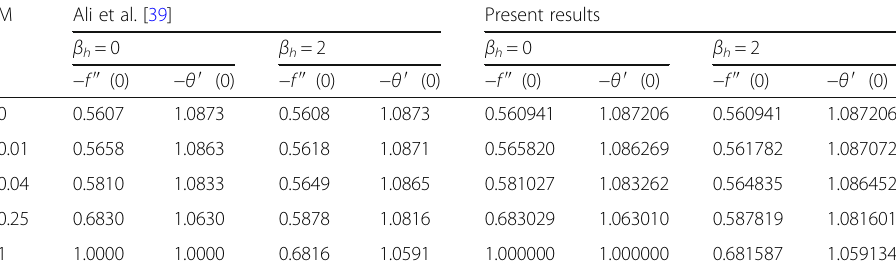
Table 2 Comparison of − f ″ (0) and − θ ′ (0) for different values of M with β h = 0, 2, λ = Pr = 1 and β i = Nr = K = Nb = Nt = Le = φ = 0